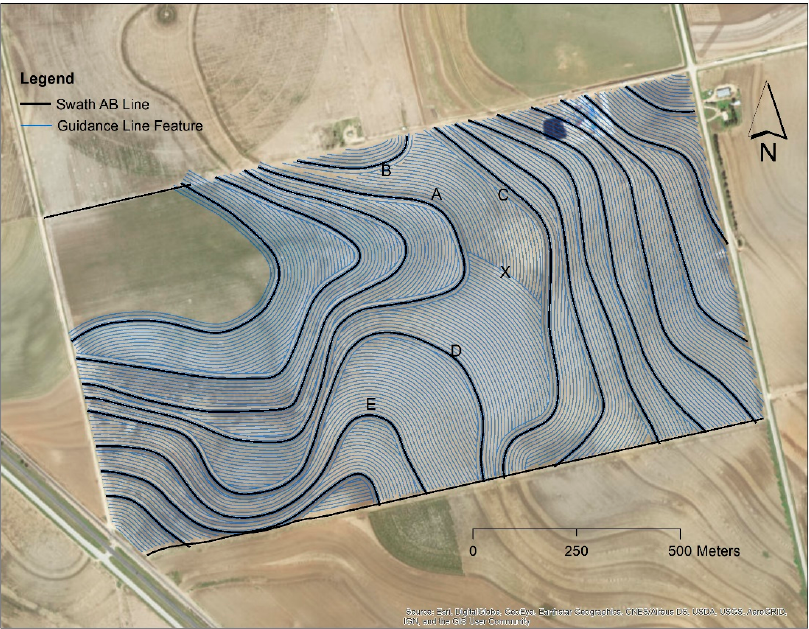
Figure 7. Guide-to-line features created for guidance in multiple land parcels to eliminate guidance confusions in between AB lines.